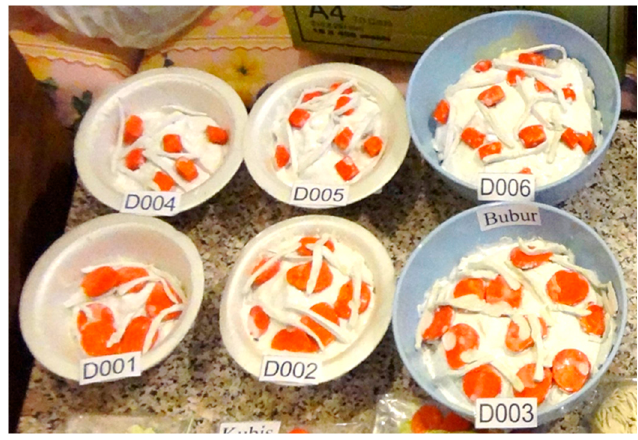
Figure 3. Food models for foodscape preferences—shape criterion (for carbohydrates).